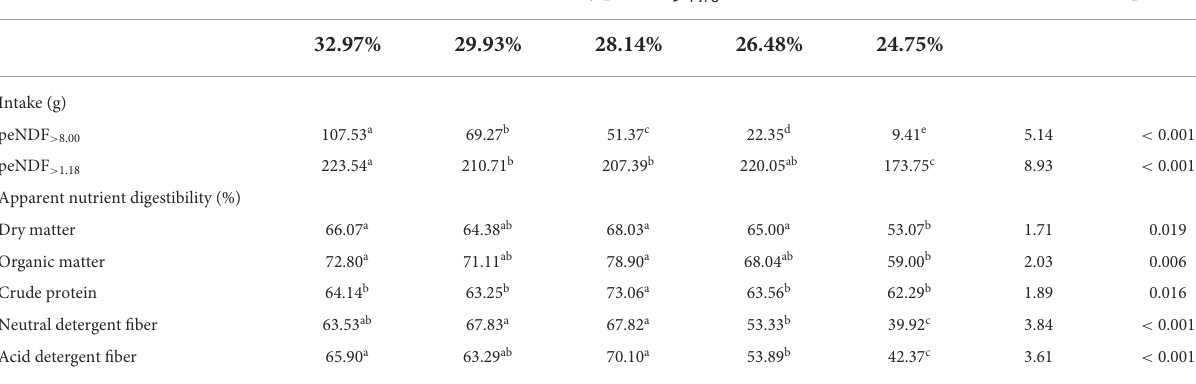
TABLE 3 Effects of different contents of peNDF > 1.18 in diets on apparent nutrient digestibility in goats.